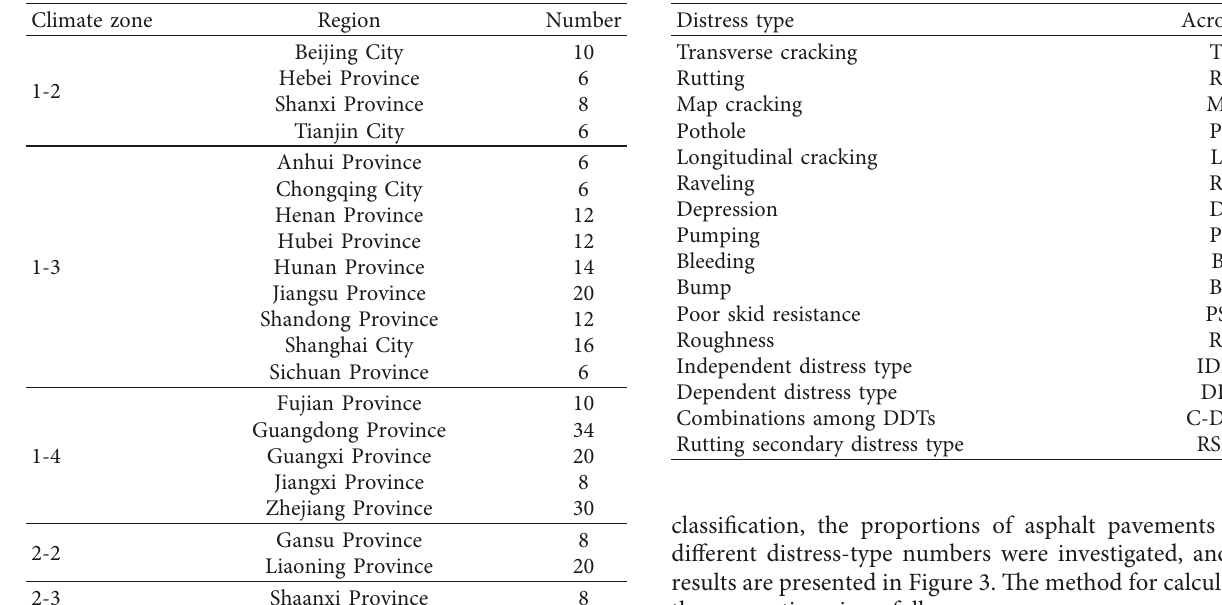
Table 2: Acronyms of distress